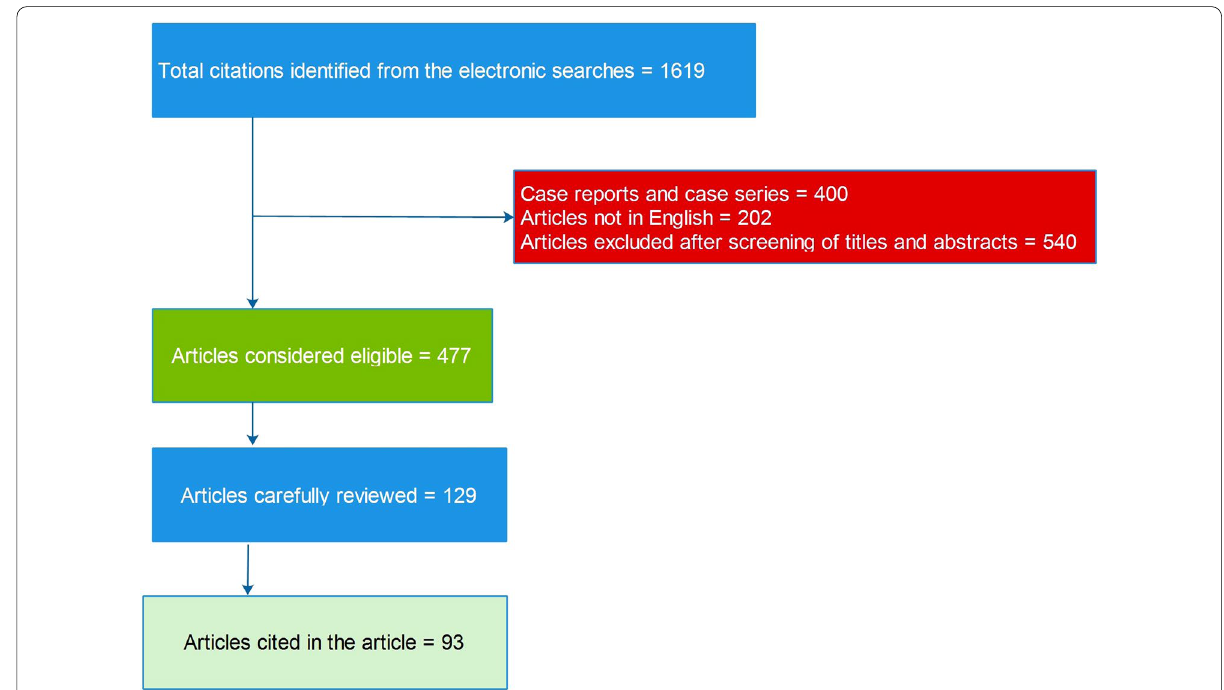
Fig. 1 Flowchart of the search